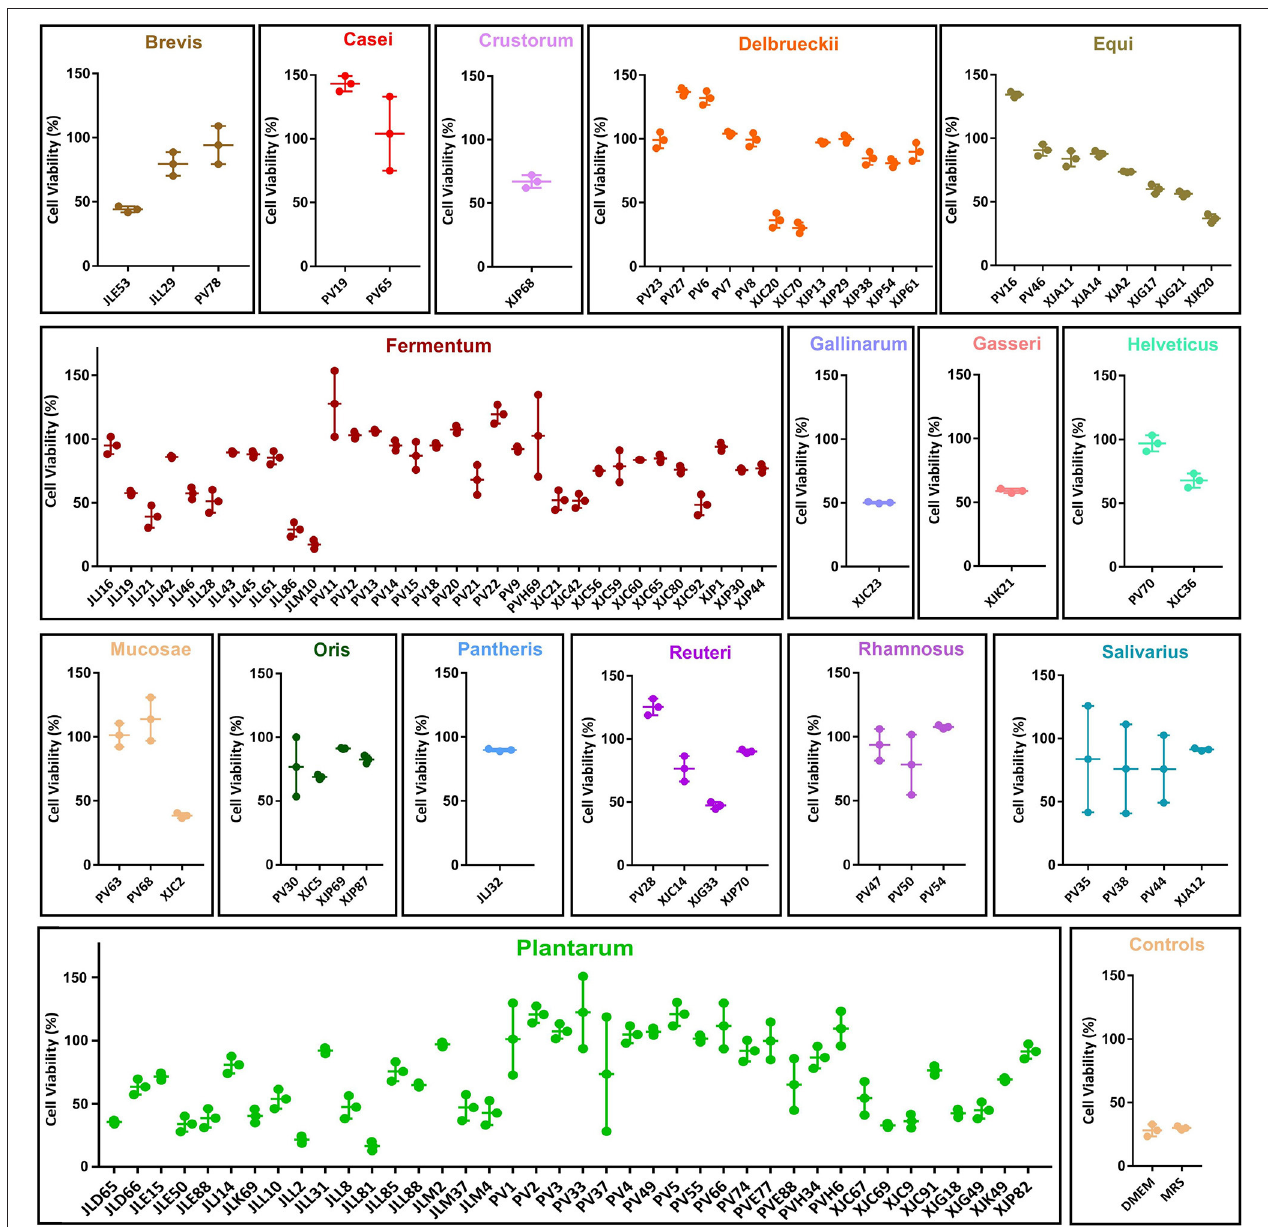
FIGURE 2 | Antiviral potential of the minimum non-toxic dilution (MNTD) of the 122 lactic acid bacteria (LAB) strains. The antiviral potentials were measured by determining RAW264.7 cell viability after 24h of incubation with MNTD-treated murine norovirus. The antiviral potentials of LAB strains are grouped according to their species. The cell viability was shown in dot and the average cell viability and the standard deviation were shown in bars.